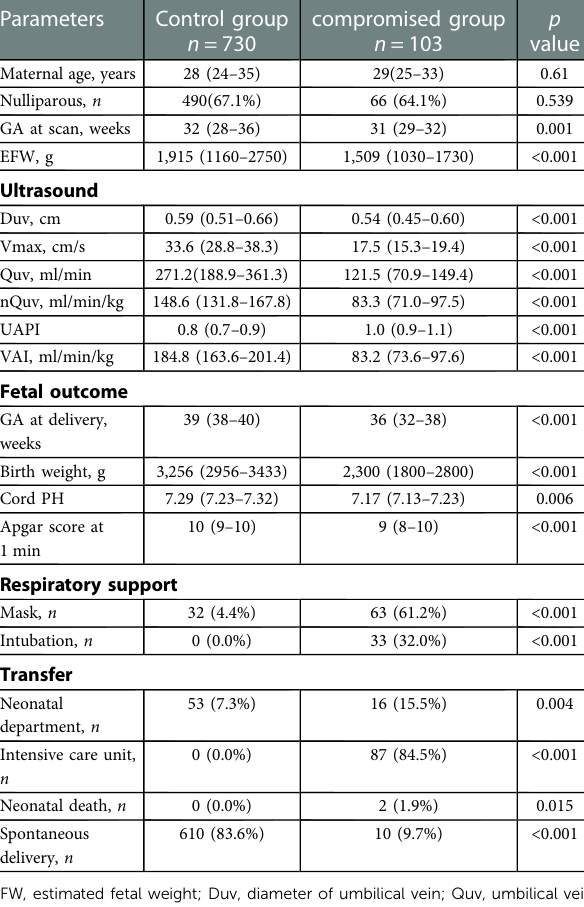
TABLE 2 Clinical and Doppler parameters of control fetuses and fetuses with compromised outcome.